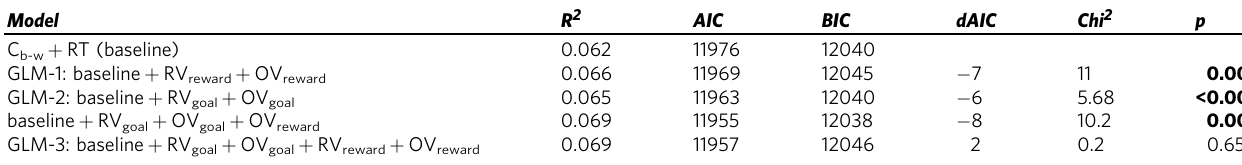
Table 3 Model comparison for reward and goal value – related BOLD activity in the valuation network ROI Model